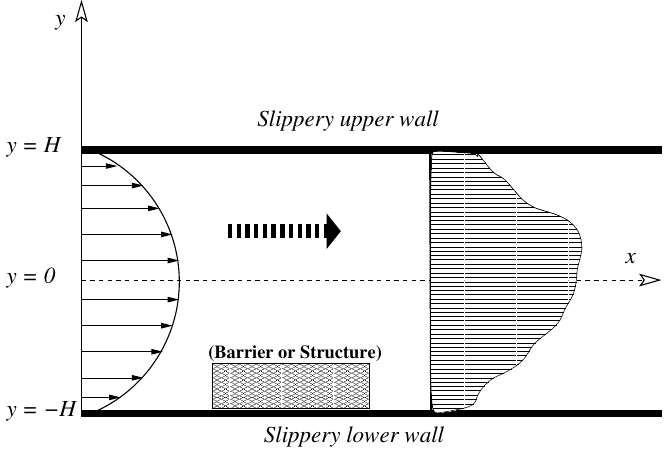
Figure 1. Schematic of the considered flow system in two-dimensional geometry. The resultant flow is asymmetric with respect the centerline of the channel ( y -axis). Slippery walls are at y = ∓ H